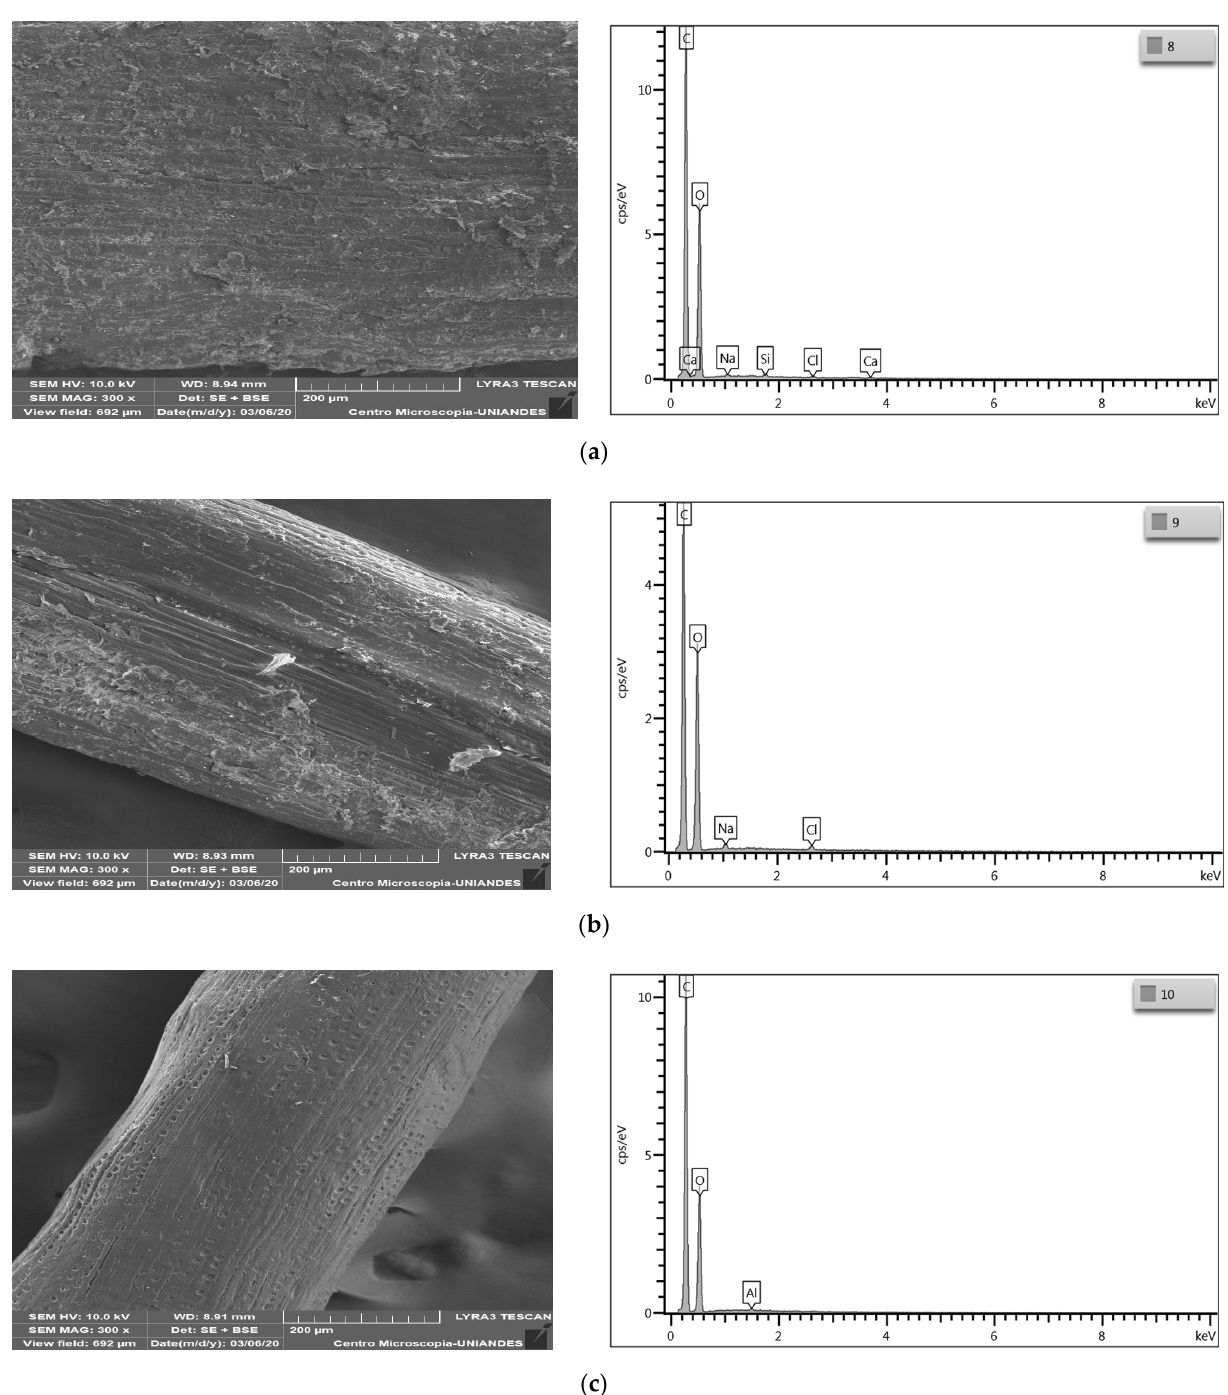
Figure 3. SEM and EDS micrographs of ( a ) coconut shell (CS), ( b ) coconut cellulose (CC) and ( c ) modified coconut cellulose (MCC).